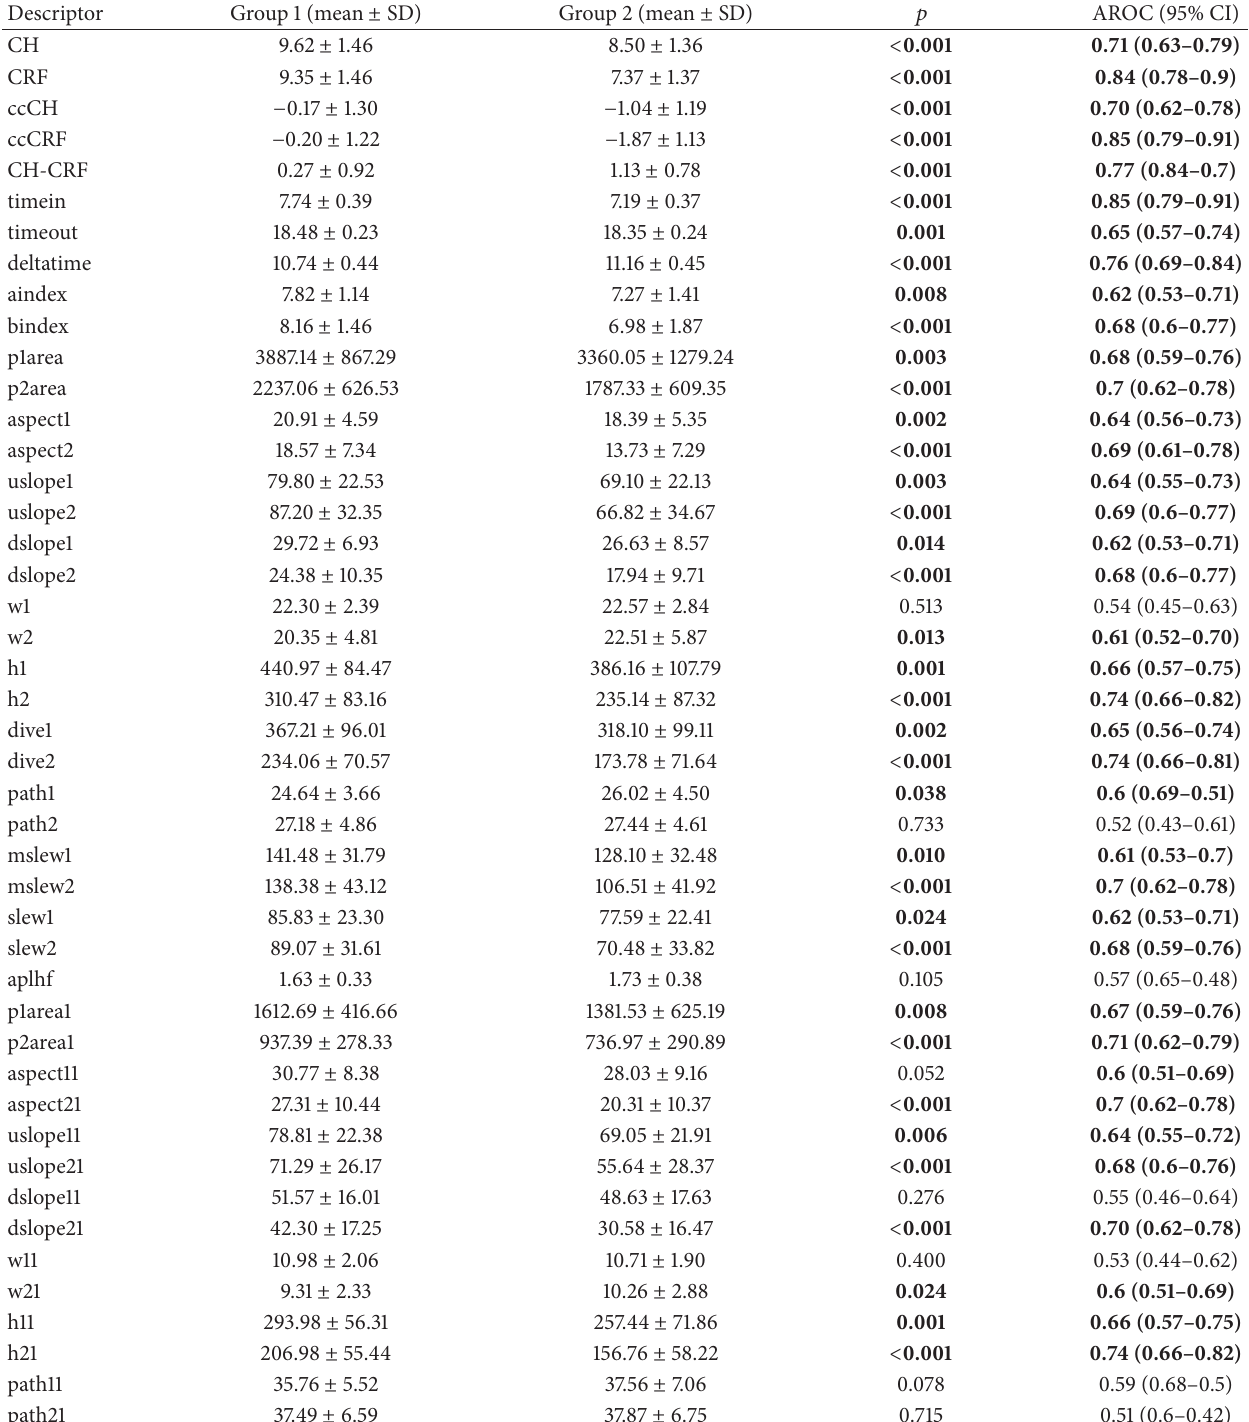
Table 2: Biomechanical descriptors in control and keratoconic eyes. Corneal waveform descriptors of control (group 1) and